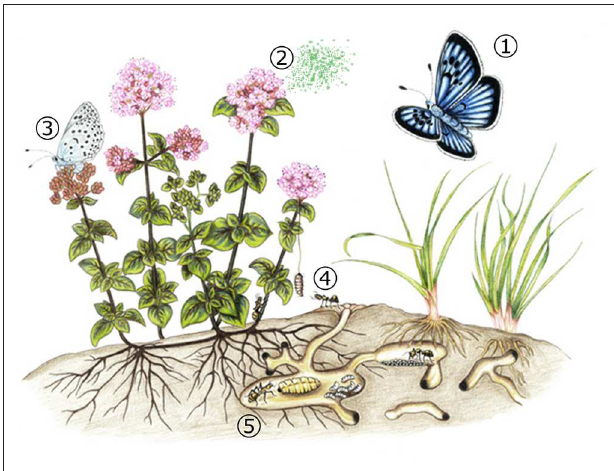
FIGURE 1 | Life cycle of Maculinea arion and its interaction with Myrmica ants and Origanum vulgare following Patricelli et al. (2015). (1) Gravid female butterflies are visually attracted to the green-red buds of O. vulgare ; when in their proximity, (2) by detecting the monoterpenoid volatile carvacrol emitted by plants co-occurring with ants of any Myrmica species (3) female lays eggs on phenologically suitable flower buds; (4) fourth-instar caterpillars leave the host plant and are “adopted” by Myrmica ants; (5) M. arion caterpillars spend 11 months within Myrmica colonies, feeding on ant brood and acquiring more than 98% of their final biomass. Artwork by Elisa